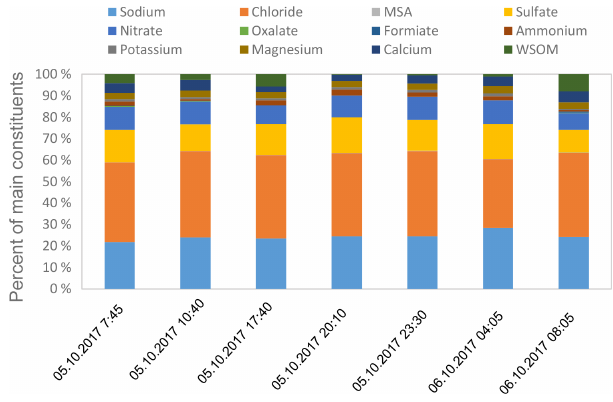
Figure 12. Cloud water composition for one connected sampling event between 5 October 7:45 (start; local time, UTC-1) and 6 Oc- tober 08:45 (start; local time, UTC −